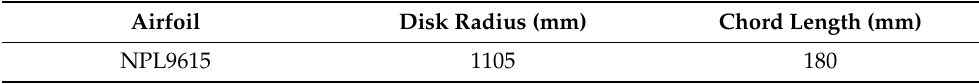
Table 1. Geometric